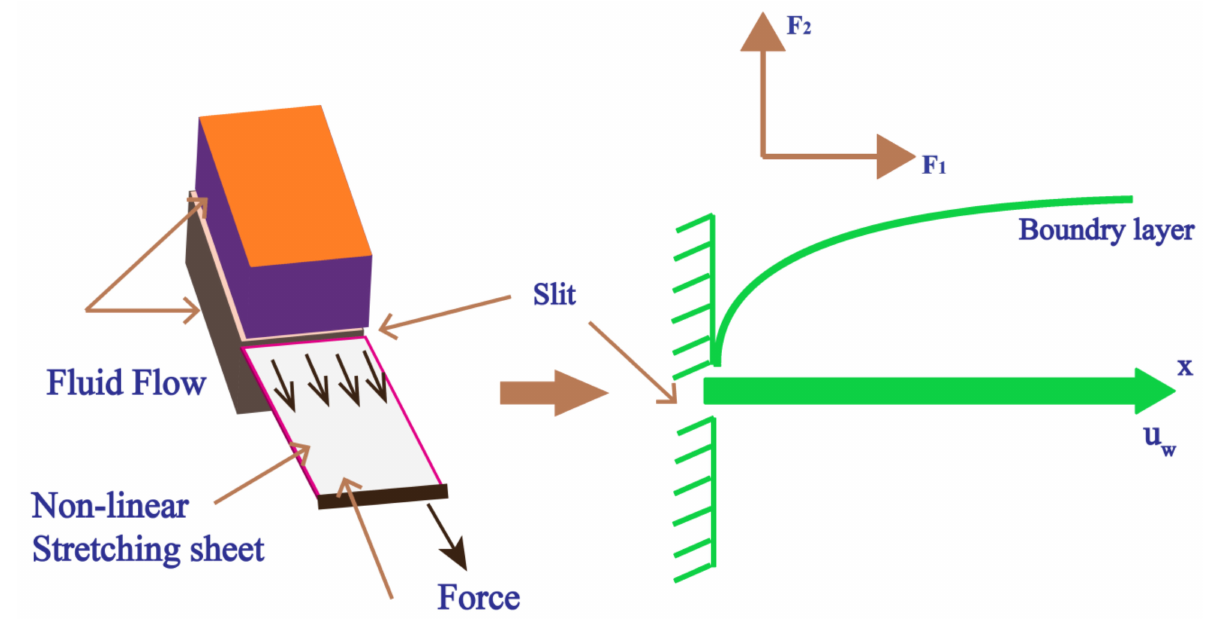
Figure 1. Diagram of the flow